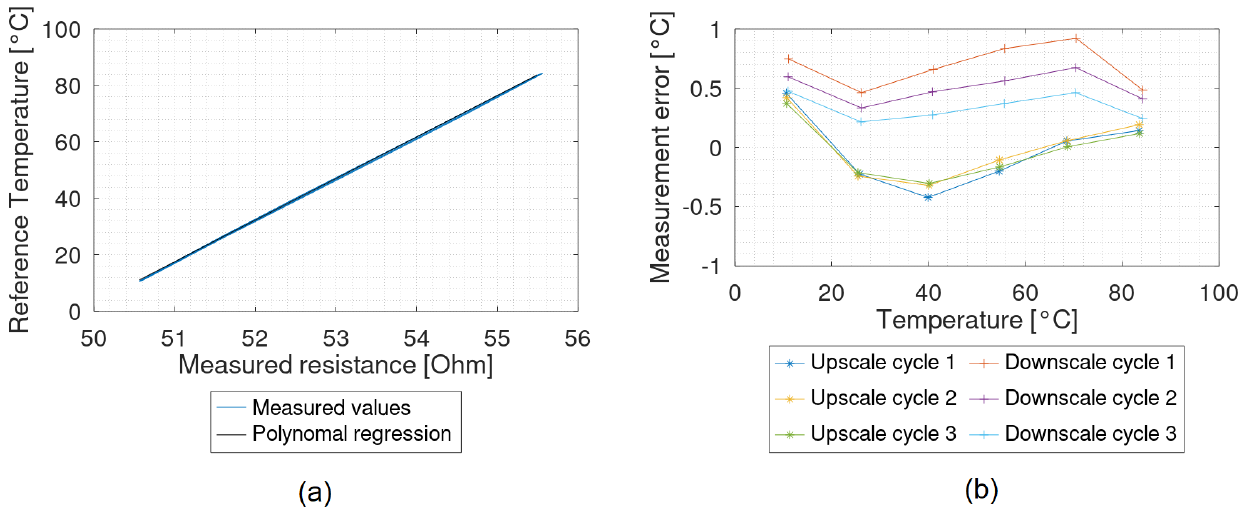
Figure 5. Results of a measurement; ( a ) characteristic curve of a sensor with a TCR of 1.31 × 10 − 3 K − 1 ; ( b ) error curve. Both graphs were generated with the same data.